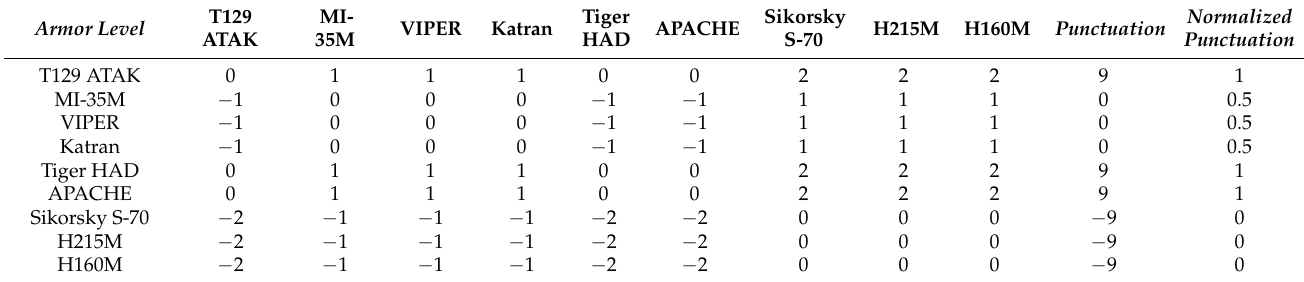
Table 9. Evaluation of alternatives under qualitative criterion Armor .